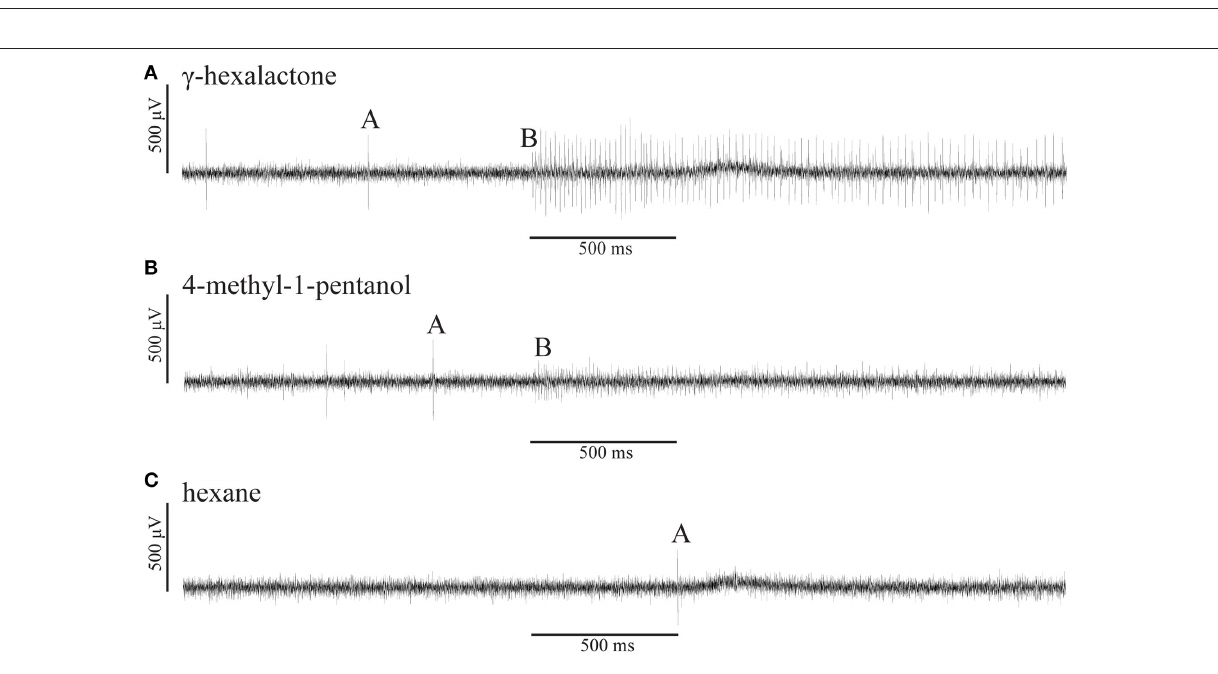
FIGURE 4 | Representative single sensillum recording (SSR) traces of a putative chemosensory M. sexta ovipositor sensilla. (A) The recorded ovipositor sensillum housed two olfactory sensory neurons (OSNs), A (larger spike amplitude) and B (smaller spike amplitude). Stimulation with γ -hexalactone elicits strong and sustained responses in the A-neuron whereas the B-neuron exhibits very weak spiking activity. (B) Excitatory, sustained response of the B-neuron (small spike amplitude) to 4-methyl-1-pentanol whereas the A-neuron did not respond to the stimulus. (C) None of the two OSNs responded to the solvent hexane alone. All odorants were diluted to a final concentration of 10 µ g/ µ l either in hexane or mineral oil. The stimulus bar (500 ms) was corrected by the system intrinsic delay of 250ms. All responses shown are from the same